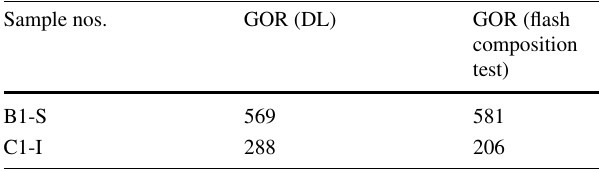
Fig. 16 Unreliable fluid sample compositions—recombination test Table 2 Observed preliminary problems Sample